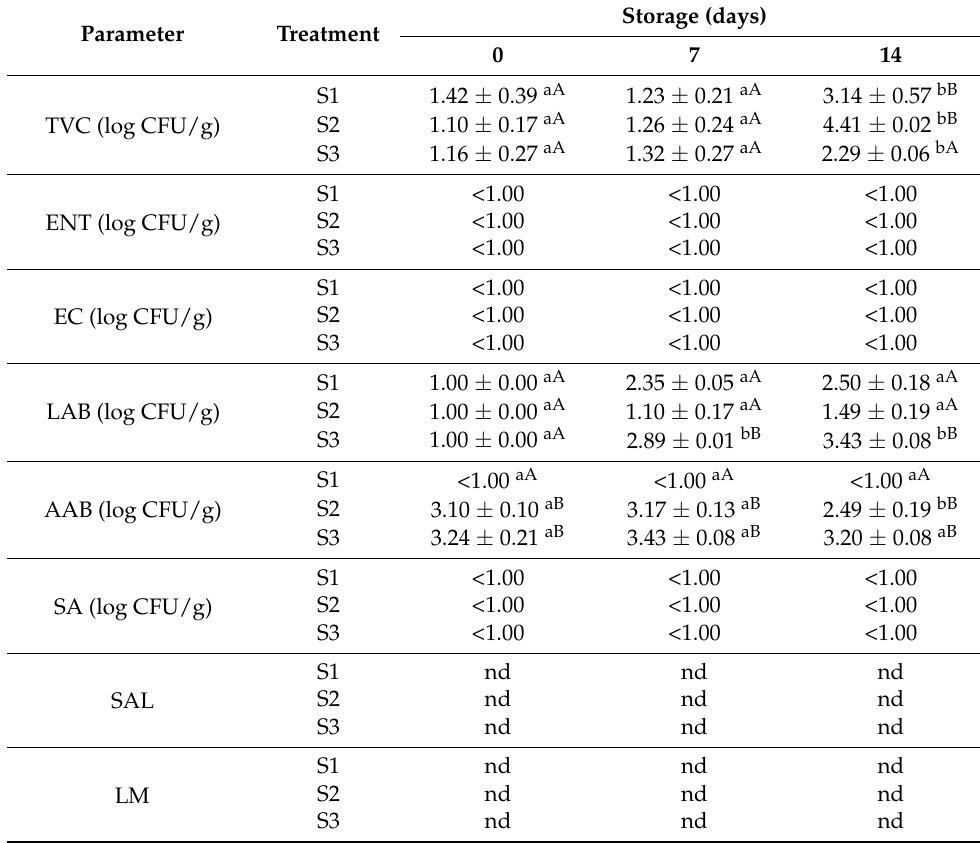
Table 4. Microbiological quality of tested pork hams.